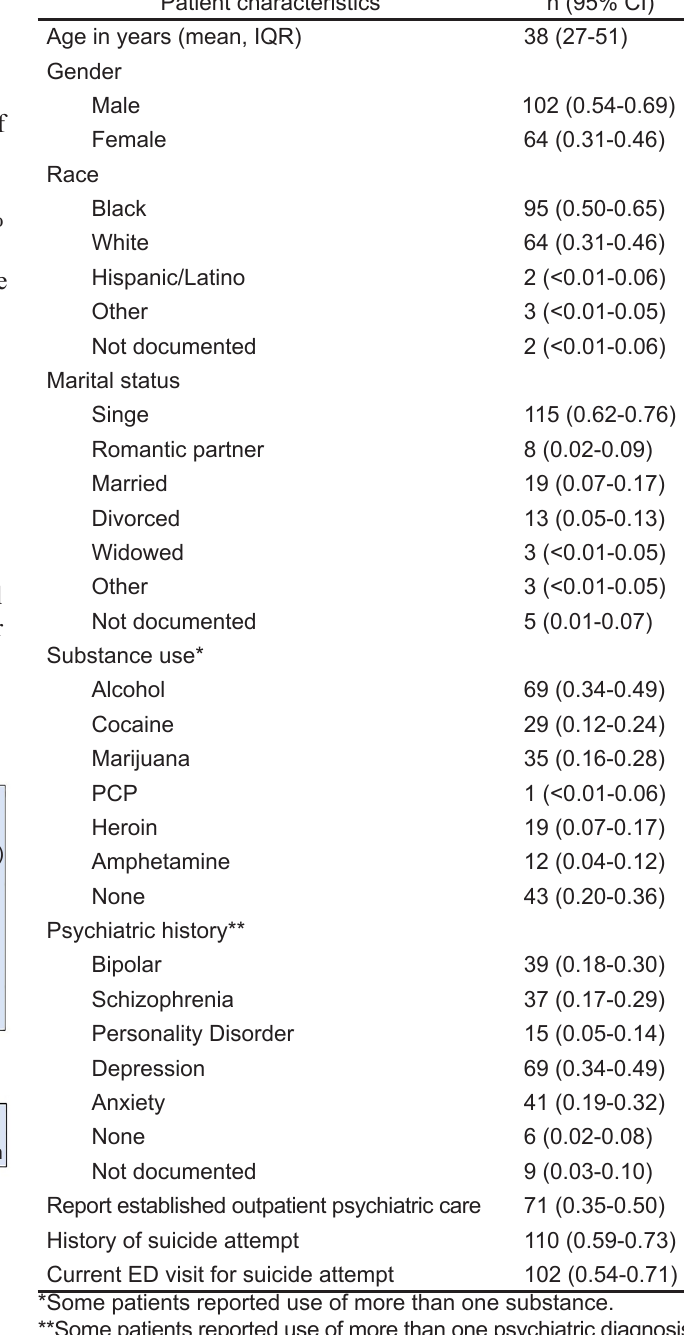
Table 1. Characteristics of patients with suicidal ideation who received intervention regarding access to lethal means.